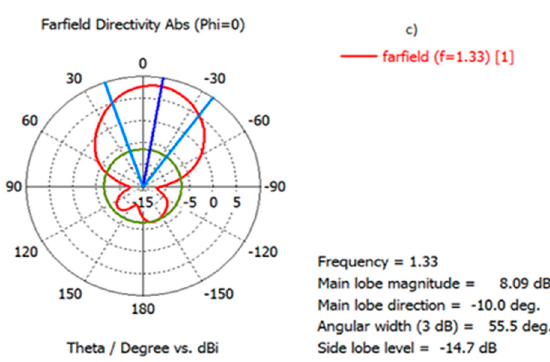
Information 2018 , 9 , x FOR PEER REVIEW